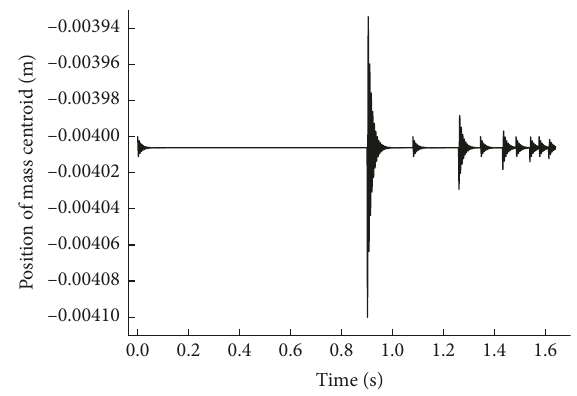
Figure 18: Centroid position of the metal plate.